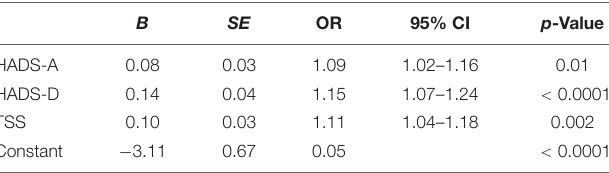
TABLE 4B | Multivariate binary logistic regression model of factors predicting insomnia in FD